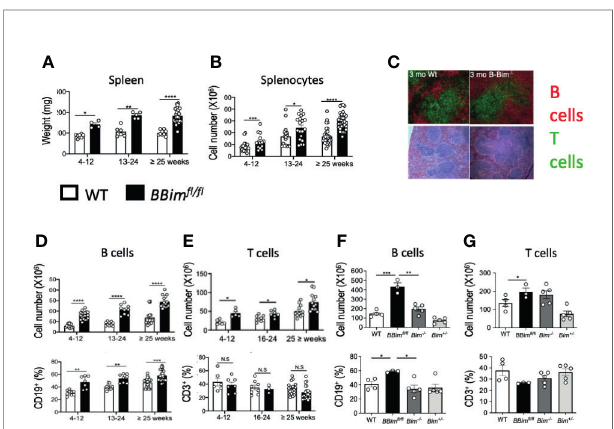
FIGURE 1 | B cell lineage-speci fi c deletion of Bim resulted in expansion of splenic B and T cells. Spleen weights and splenocyte numbers, B cells and T cells were identi fi ed by FCM using established cell surface markers as described in materials and methods. (A) Spleen weights at different ages from BBim fl / fl and WT mice. (B) Total splenocyte numbers. (C) Immuno fl uorescence image showing splenic follicles (top panel) stained for B220+ B cells (red) and CD3+ T cells (green) and H&E images (bottom panel) showing follicular structure and lymphocyte organization (top panel) of spleens from 3 month old mice. (D) Numbers (top panel) and proportions (bottom panel) of splenic (D) B cells and (E) T cells. (F, G) Quanti fi cation of splenic B and T cells in BBim fl / fl relative to Bim -/- mice. Numbers (top panel) and proportions (bottom panel) of (F) B cells and (G) T cells. Data is representative of >3 independent experiments. Not signi fi cant (N.S) P > 0.05, *P ≤ 0.05, **P ≤ 0.01, ***P ≤ 0.001, ****P ≤ 0.0001, calculated by Students T- test and Mann-Whitney non-parametric